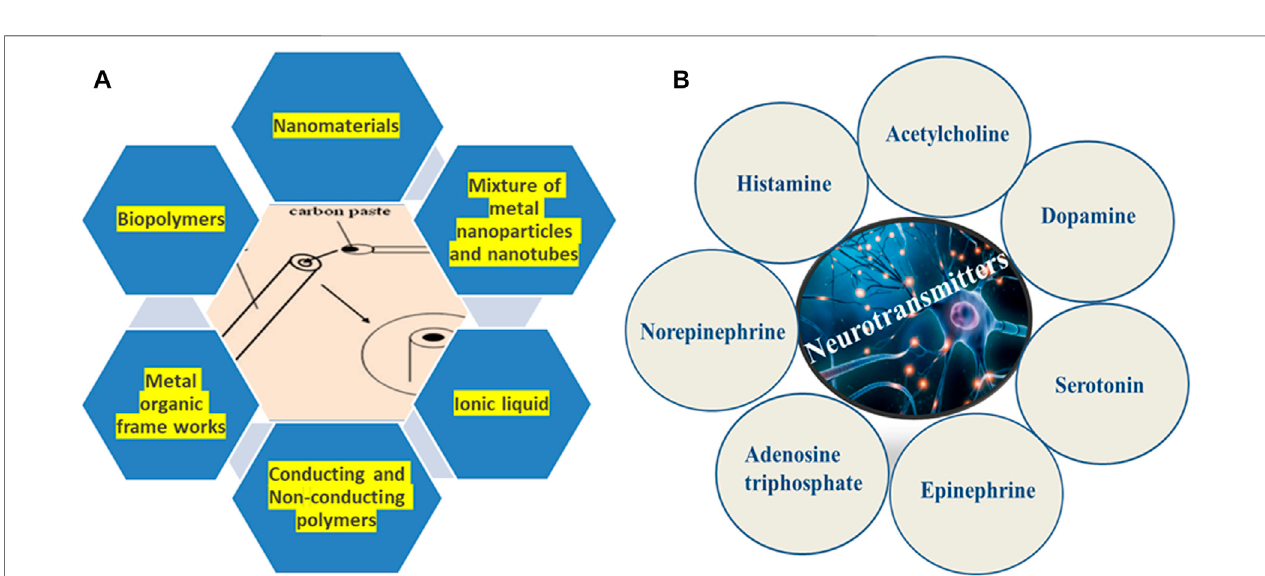
FIGURE 3 | (A) Different types of modi fi cations on CPE (B) Neurotransmitters.